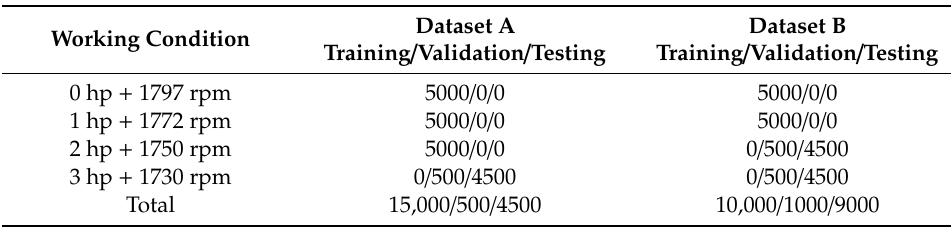
Table 2. Details of the two datasets in Case One.